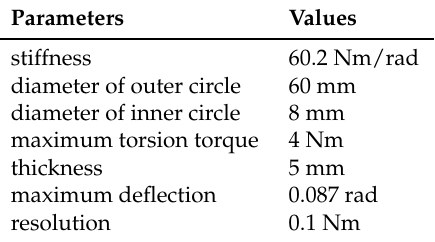
Table 2. Properties of the elastic module.